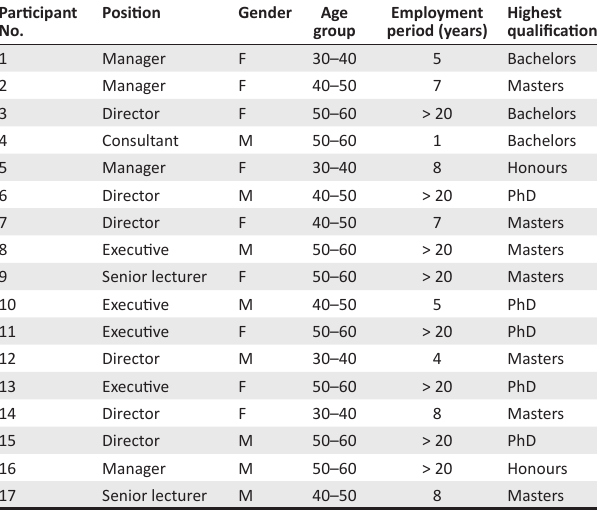
TABLE 2: Demographic profile of the